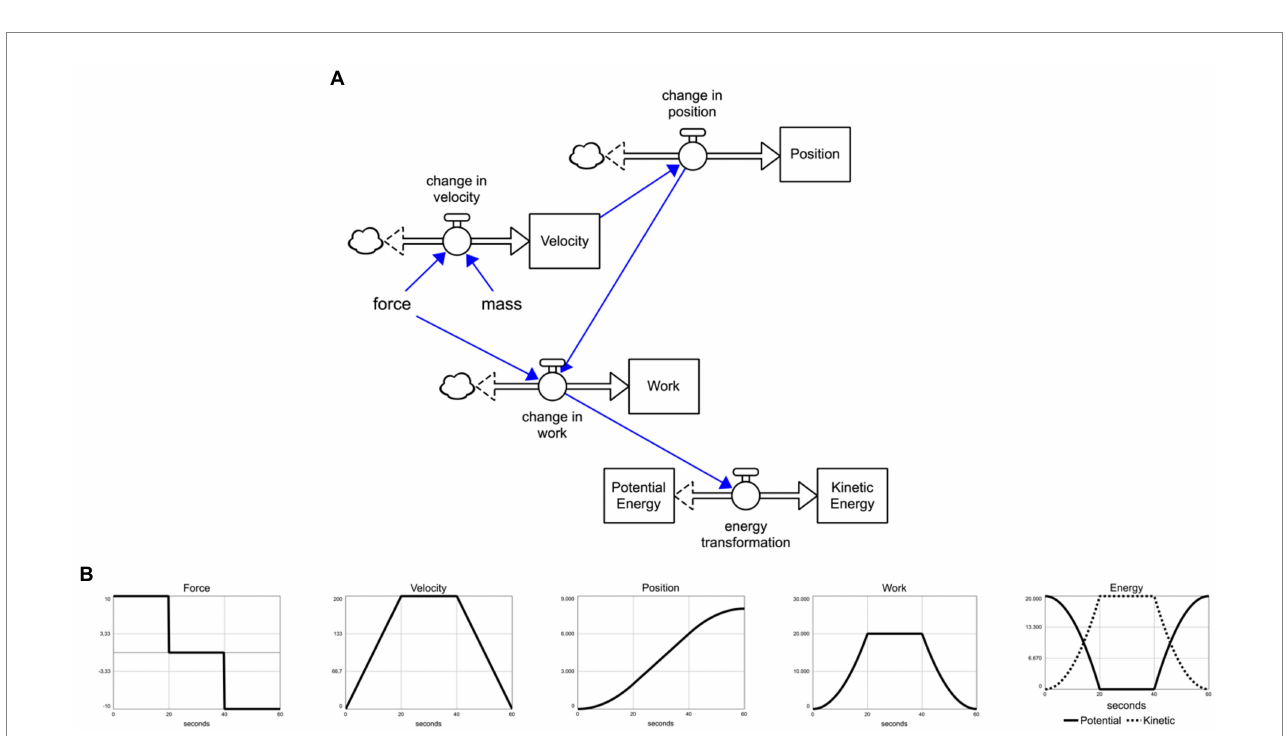
FIGURE 7 A stock-flow model (A) of important concepts involved in classical mechanics, including several behaviors (B) produced by the model.